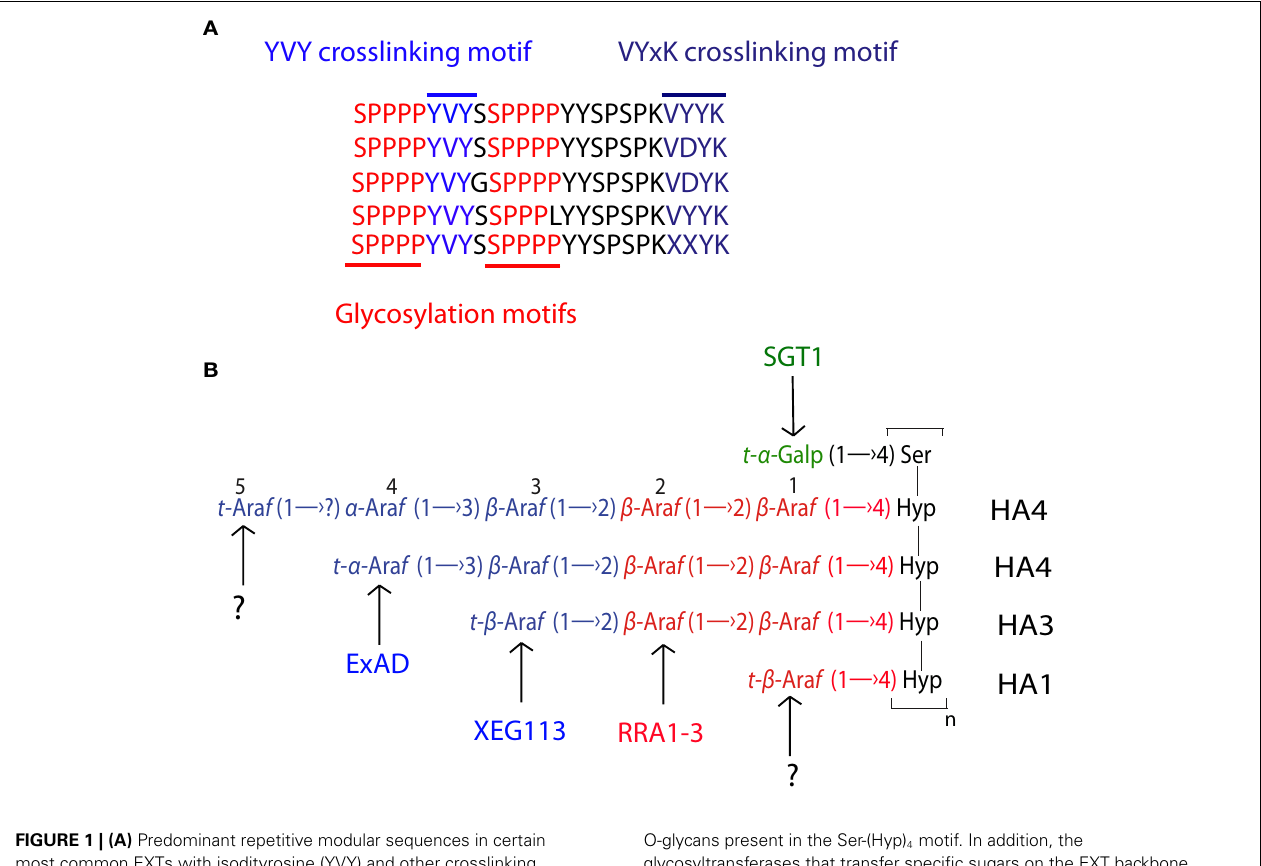
FIGURE 1 | (A) Predominant repetitive modular sequences in certain most common EXTs with isodityrosine (YVY) and other crosslinking sites (VYxK) as well as the Ser-(Hyp) 4 , which is O-glycosylated. (B)